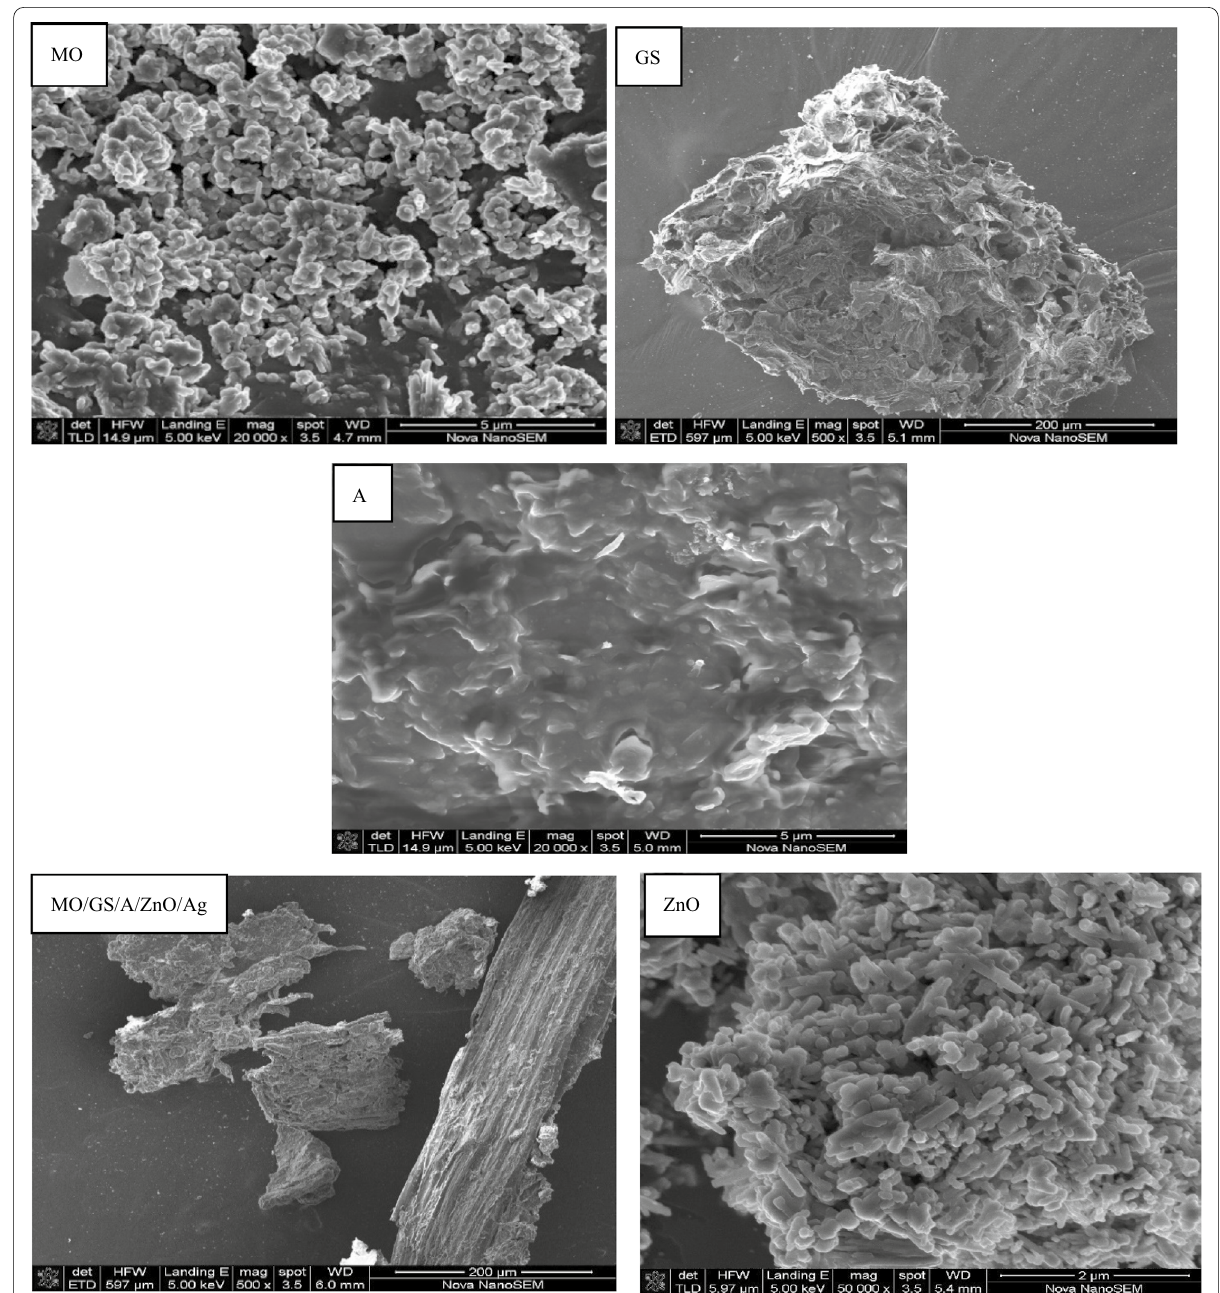
Fig. 5 SEM images of the raw materials (MO, GS and A) and synthesized materials (MO/GS/A/ZnO/Ag and